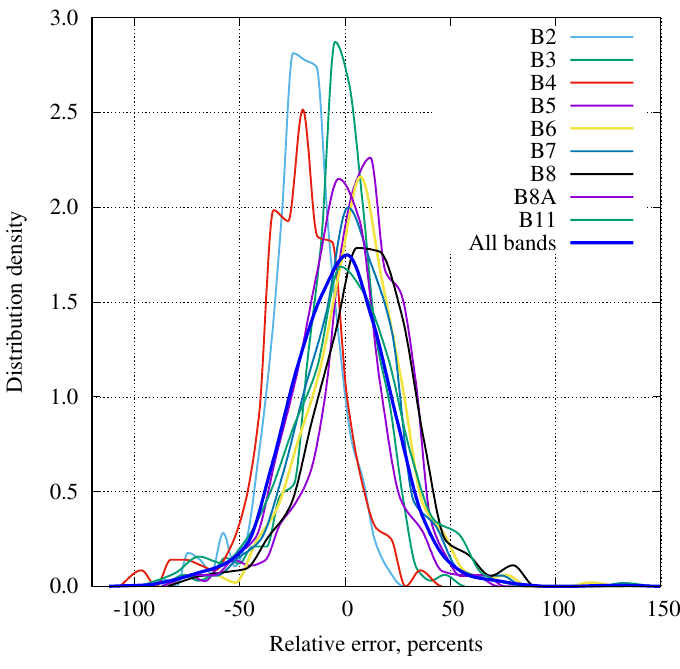
Figure 10. Relative errors of simulated spectra, spruce